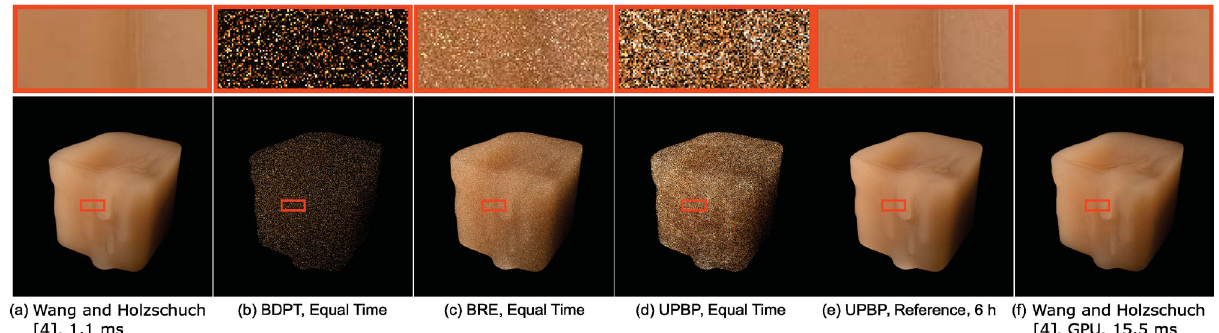
Fig. 9 Comparison between Ref. [4] and other volumetric methods for a wax object. For this material, with a large albedo α and a small mean free path (cid:3) , multiple scattering effects dominate. Reproduced with permission from Ref. [4], c (cid:2) The Author(s)